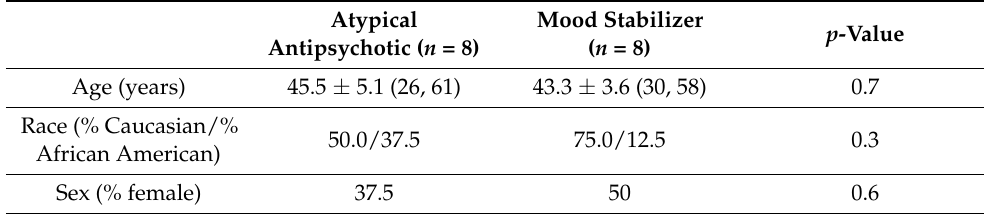
Table 1. Description of Clinical Sample Population. Values presented as mean ± s.e. with range (min, max) or percent. Average length on treatment refers to antipsychotic or mood stabilizer. BMI = Body Mass Index; * reflects the number of months that have elapsed since the medication was first